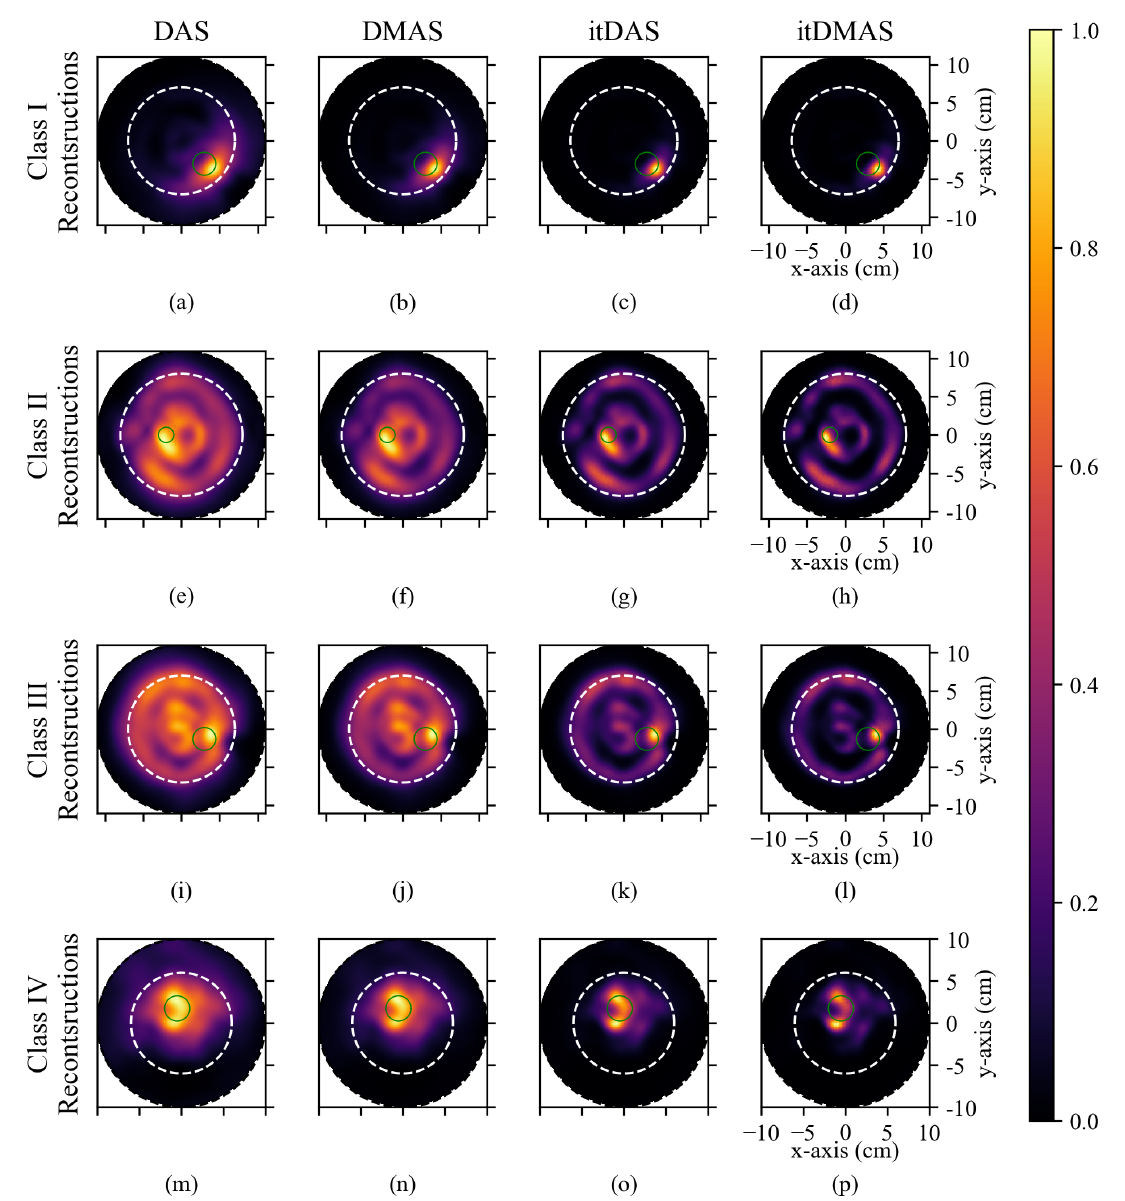
Figure 3. Reconstructions of breast phantoms by (left to right) the DAS, DMAS, itDAS, and itDMAS beamformers. ( a – d ) display the reconstructions of a 15 mm radius lesion in a Class I (A2F1) phantom, ( e – h ) display the reconstructions of a 10 mm radius lesion in a Class II (A3F4) phantom, ( i – l ) display the reconstructions of a 15 mm radius lesion in a Class III (A2F4) phantom, and ( m – p ) display the reconstruction of a 15 mm radius lesion in a Class IV (A1F4) phantom. Each image is normalized to its maximum intensity. The dotted black circle indicates the antenna trajectory during the scan, the dotted white line indicates the approximate breast phantom boundary, and the solid green circle indicates the known tumor